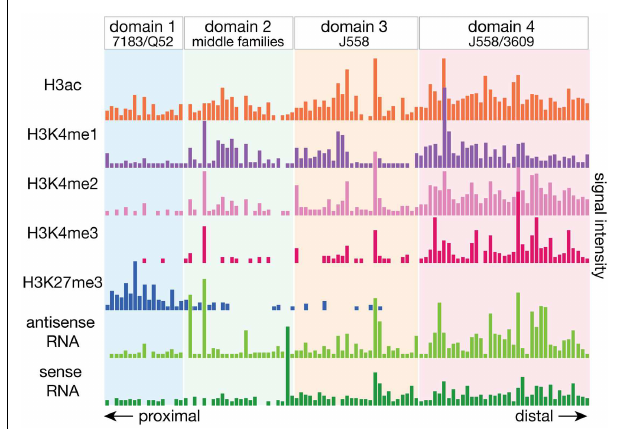
FIGURE 3 |The Igh locus can be divided into four domains by the epigenetic and transcriptional landscape .The local epigenetic and transcriptional environment of each gene is plotted, with the numbers deriving from the total number of ChIP-seq or RNA-seq reads for the 2.5kb region centered around eachV H gene. Active histone modifications and ncRNA transcripts were enriched atV H genes at the distal end of the locus while proximal genes had very little of these features. Domains were divided by the boundary ofV H gene families, and bioinformatic analyses of the various epigenetic elements suggest that genes in each domain may be regulated by different